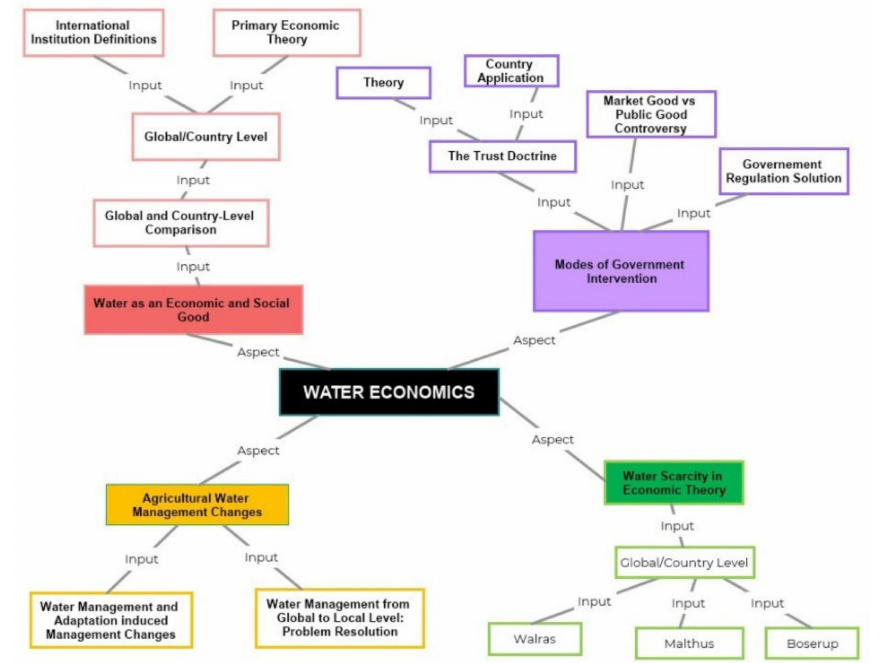
Figure 1. Methodology connection chart.